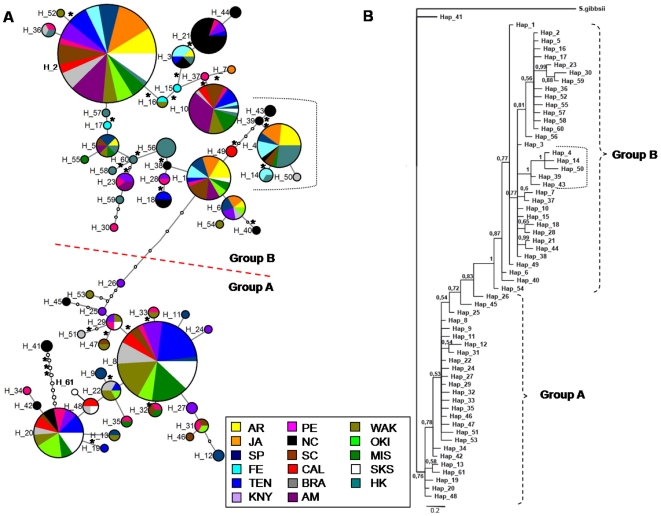
Network and phylogeny for ANT.a) Median-joining allele network for Styela plicata using ANT results. Area of circles is proportional to the number of individuals found for each allele. Partitions inside the circles represent the proportion of each population within each allele. Small circles represent missing alleles. Lines between circles represent one mutational step and non-synonymous substitutions are indicated with an asterisk; b) Phylogeny of partial ANT gene sequences using Bayesian inference. The congeneric species Styela gibbsii was used as an outgroup. Posterior probabilities are indicated when >0.5. The dot line mark the clade corresponding to sequences with a 22 amino acid deletion.